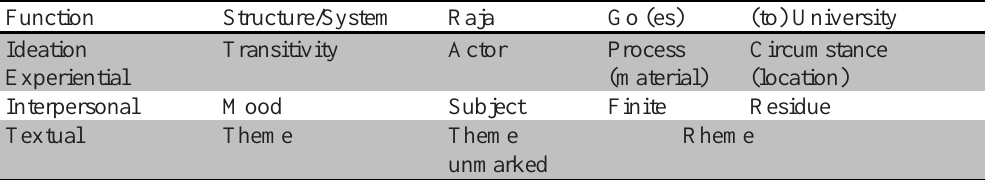
Meta-functional interpretation of a clause positions its simultaneous functions of meanings, structures, grammatical units, and organization. This illustration evokes both intrinsic and extrinsic functions of